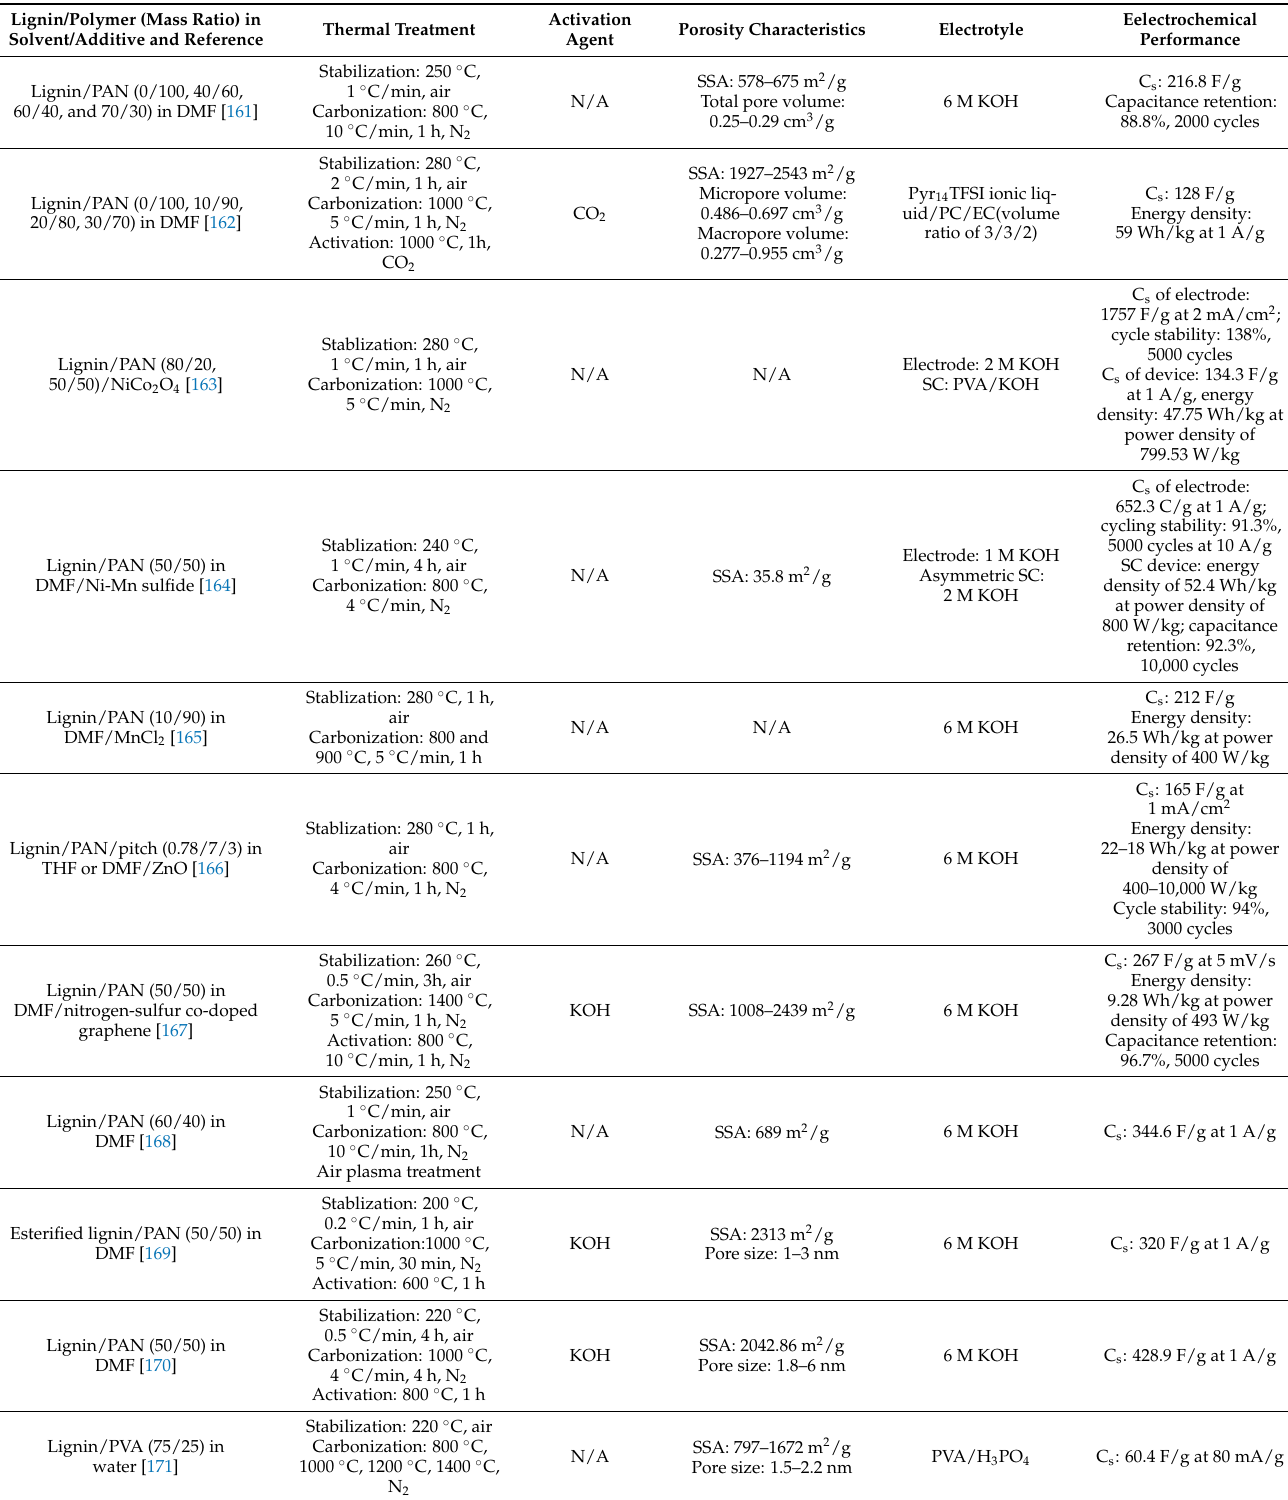
Activation Agent Porosity Characteristics Electrotyle